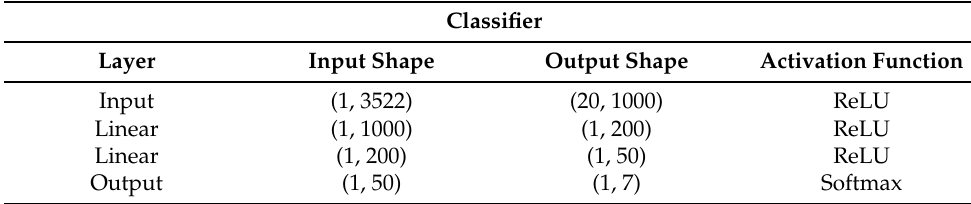
Table 3. Parameters of Classifer.